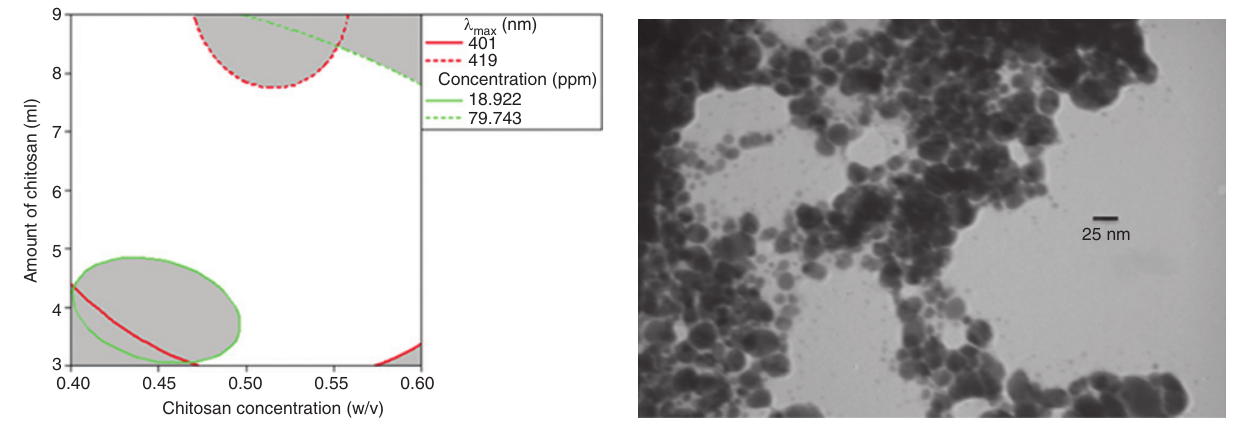
Figure 6: Overlaid contour plot of silver nanoparticles (AgNPs) λ and concentration with acceptable levels as function of amount and concentration of chitosan solution.